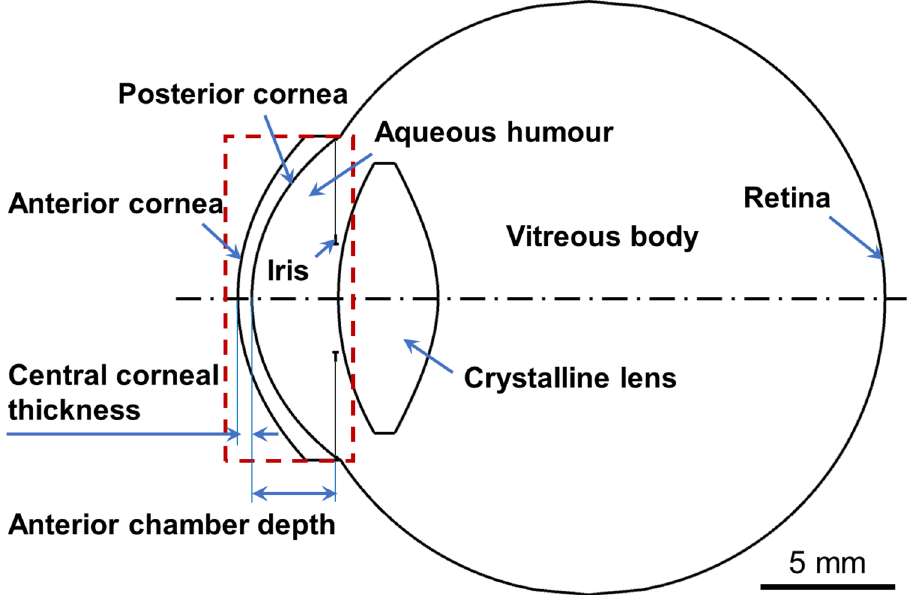
Figure 1. Schematic of a customized human eye model to access the ocular structure change in response to femto-LASIK. The customized eye model was started from a schematic eye model 29 and then was built by replacement of the measured or estimated ocular biometric